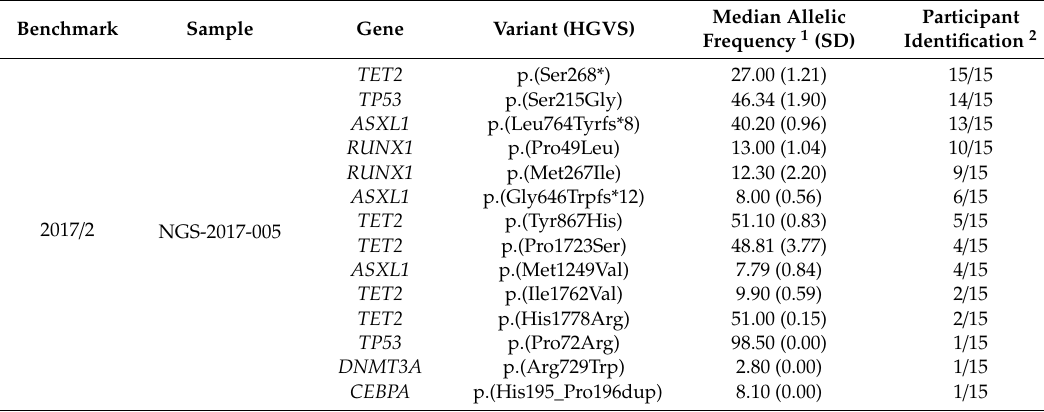
Table 4. Participant results for informative variants per